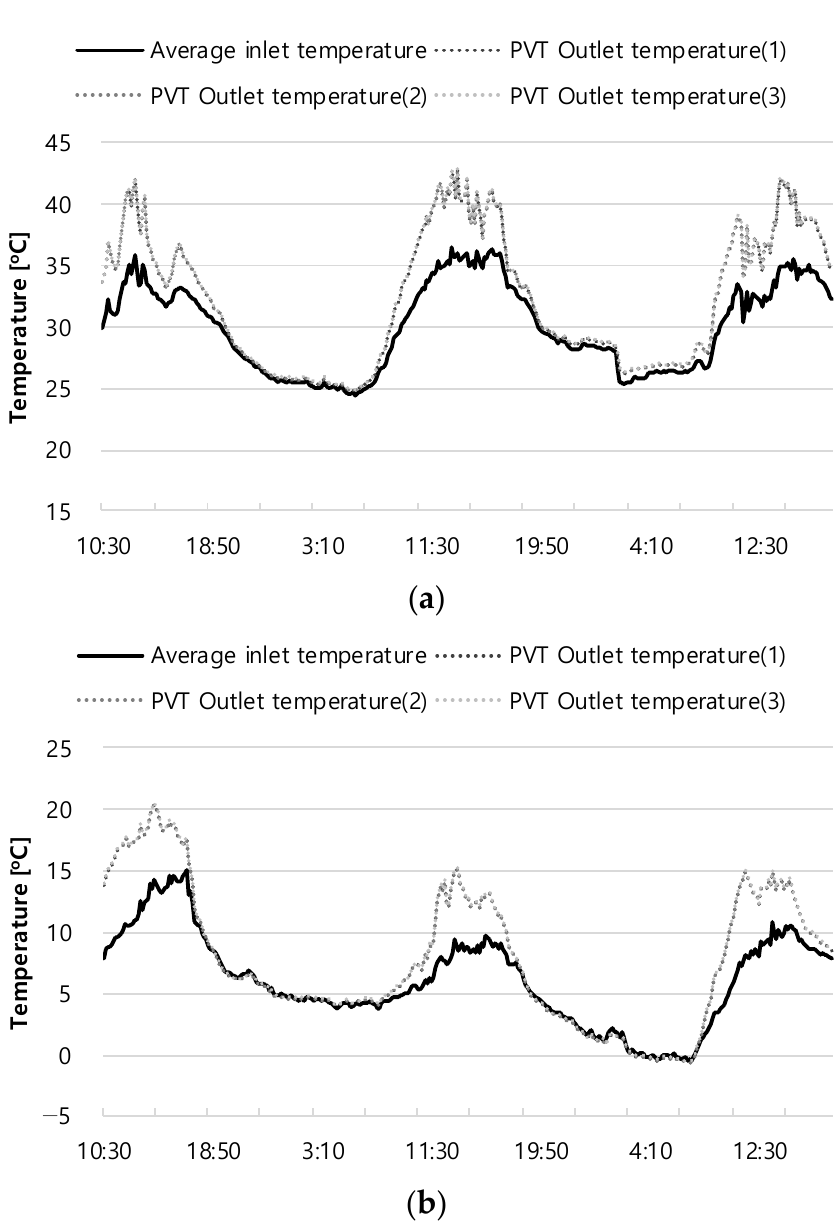
Figure 5. Outlet temperature of PVT panel: ( a ) summer; ( b ) winter.